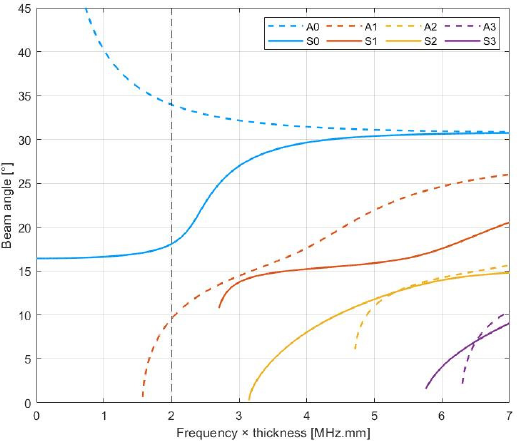
Figure 4. Beam incidence angle needed to generate Lamb modes in an immersed plate.